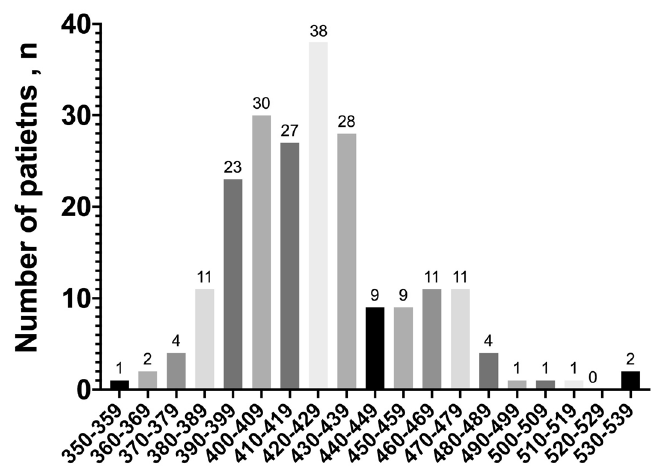
Figure 1. Distribution of patients according to the QTc interval during treatment, at 10 ms intervals. Only 2.9% (n = 6) of patients presented a QTc of more than 480 ms. Among the 4 patients presenting a QTc interval of ≥ 500 ms, 3 showed a wide QRS due to intraventricular conduction defects (left bundle branch block or right bundle branch